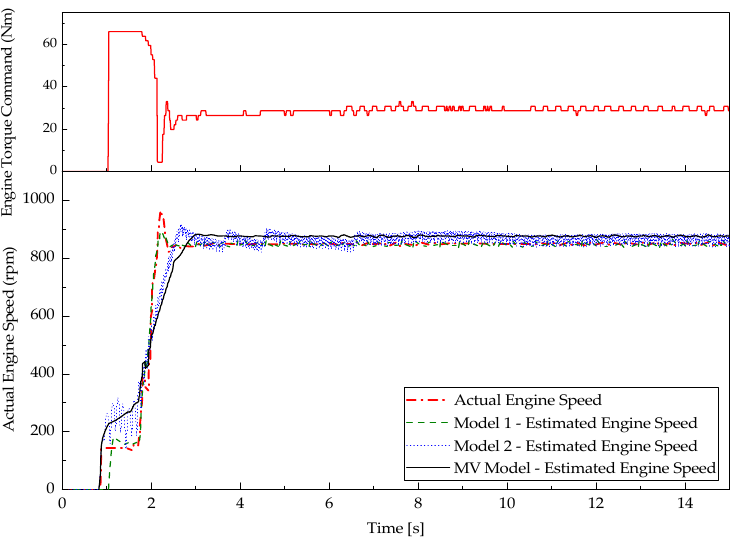
Figure 12. Validation results of three powertrain models with respect to the first cranking experiment.